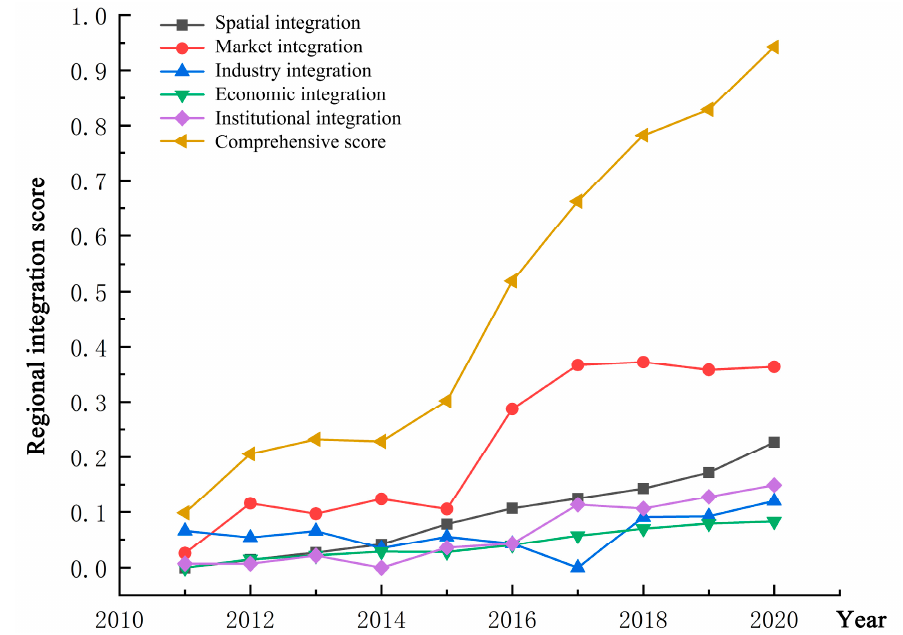
Figure 3. Evolution of regional integration of CCUA.